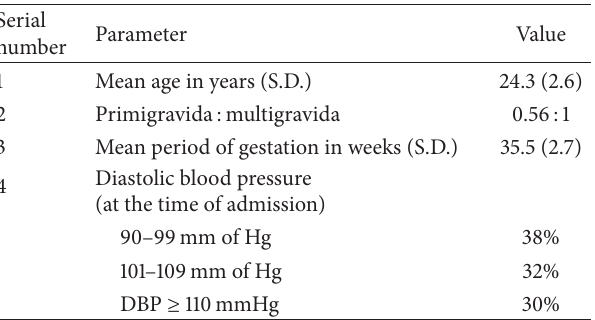
Table 1: General characteristics of the